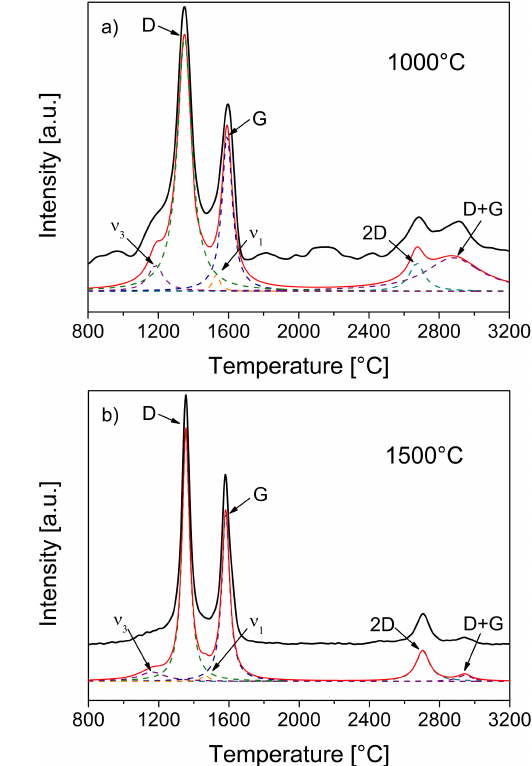
Figure 1. Raman spectra of C/SiOC (13.5vol%C) at 1000 (a) and 1500 ◦ C (b) . Dashed lines represent the deconvoluted spectra.